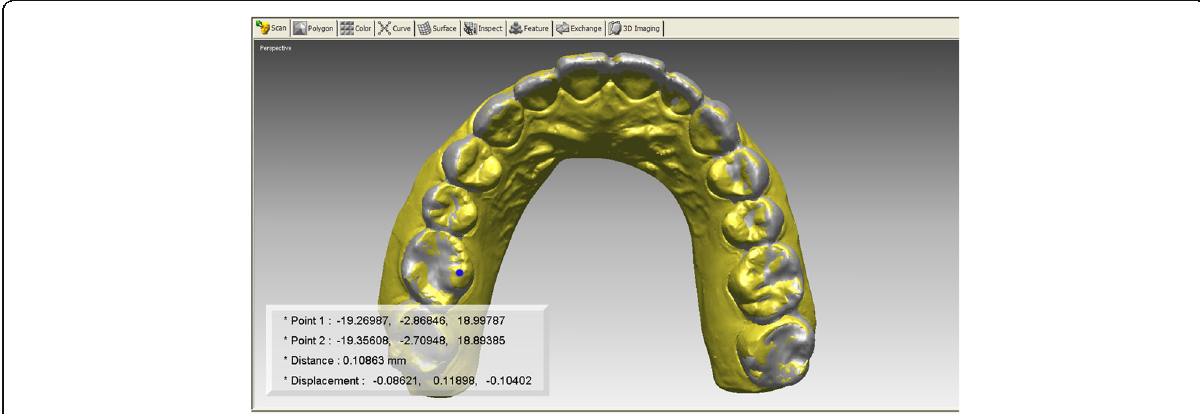
Fig. 2 Discrepancies in the three-dimensional direction were calculated in the incisor and molar regions. Three reference points were selected, and the point-to-point distance between each point on the intraoral scan and the corresponding model scan was computed. The point-to-point distance was regarded as the displacement of the intraoral scan to the model scan, and the relative distance was